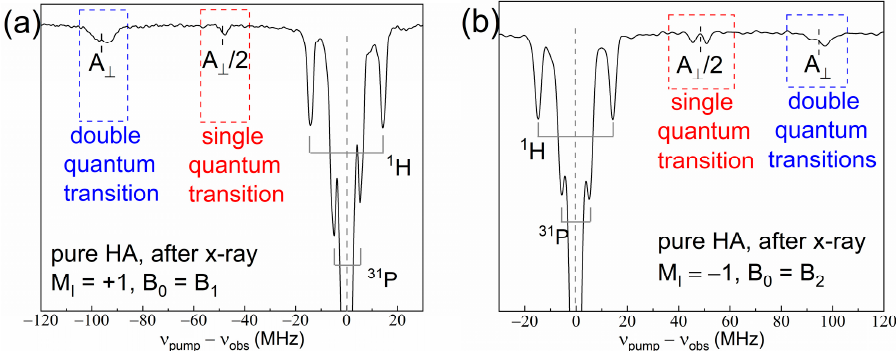
Figure 3. Total EDNMR spectra of HA according to the quantum number M I : ( a ) M I = +1 at B 0 = B 1 , ( b ) M I = − 1 at B 0 = B 2 (see Figure 1a). ( b ) M I = − 1 at B 0 = B 2 (see Figure